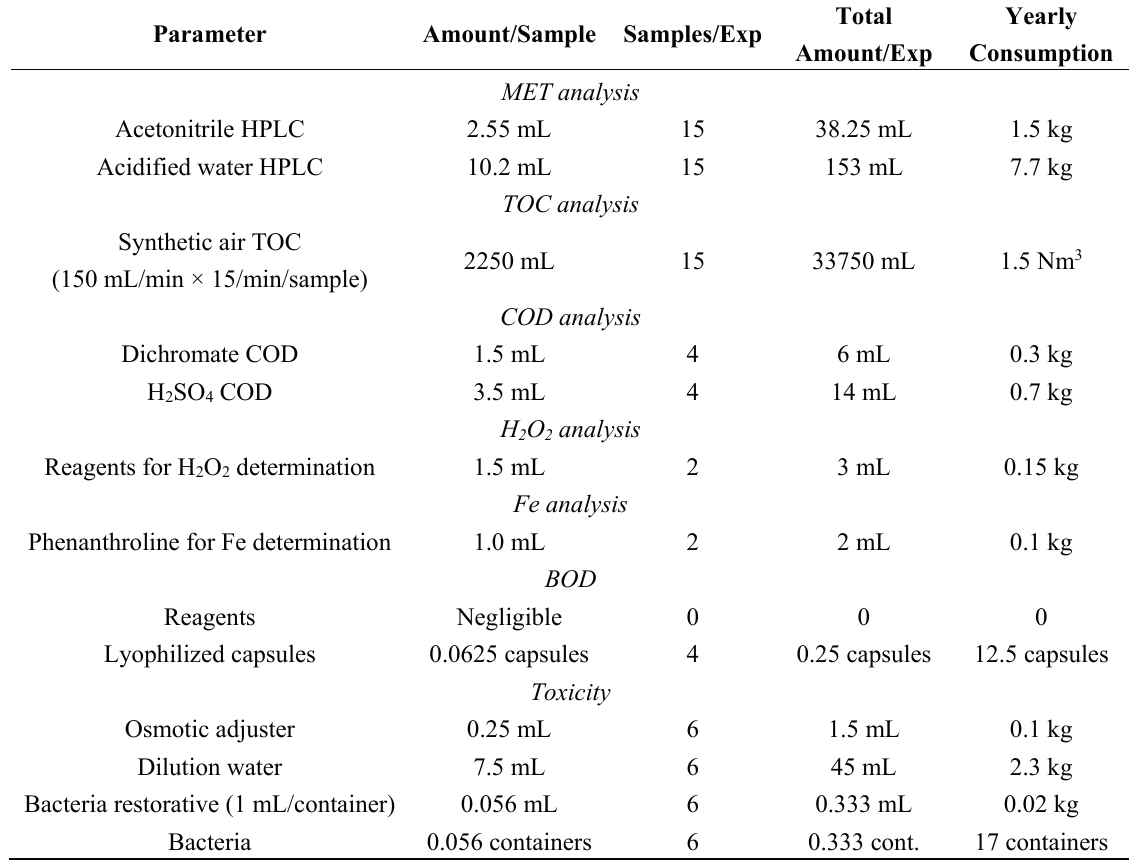
Table 9. Reagent consumption in photo-Fenton experiment analyses for 50